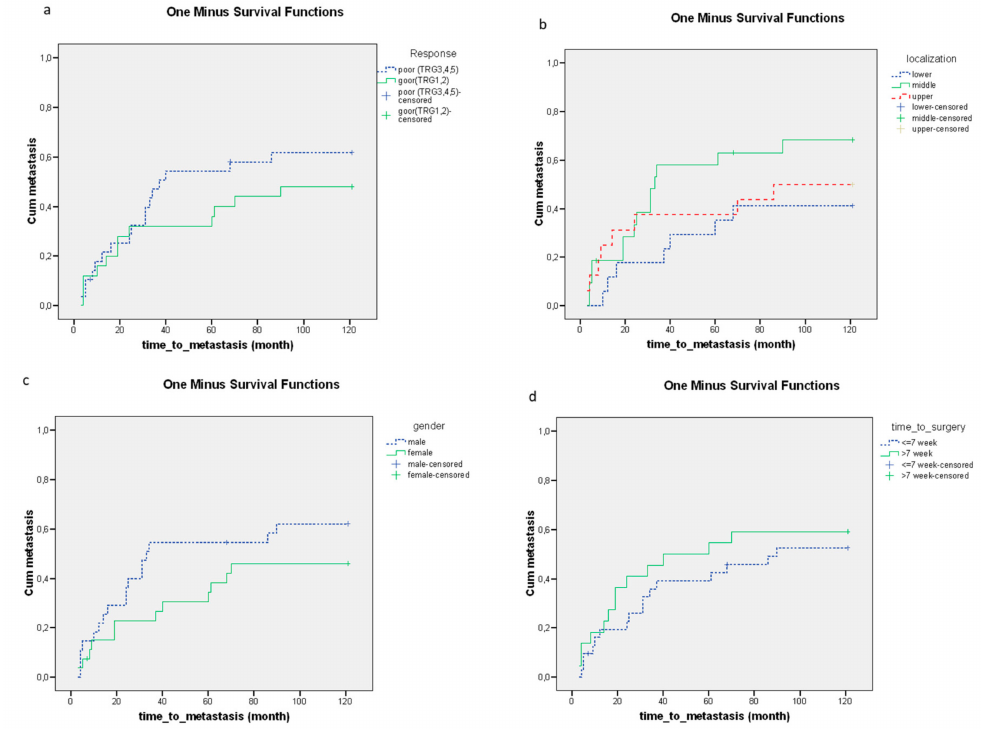
Figure 4. The relationships between clinical parameters including the ( a ) histopathological response ( p = 0.170), ( b ) tumor localization ( p = 0.048), ( c ) gender ( p = 0.064), ( d ) time to surgery ( p = 0.319) and time to metastasis. The effects of clinical parameters on the time to metastasis were demonstrated using Kaplan–Meier curves and the level of significance was determined using the log-rank test. Probability ( p ) values < 0.05 were considered statistically